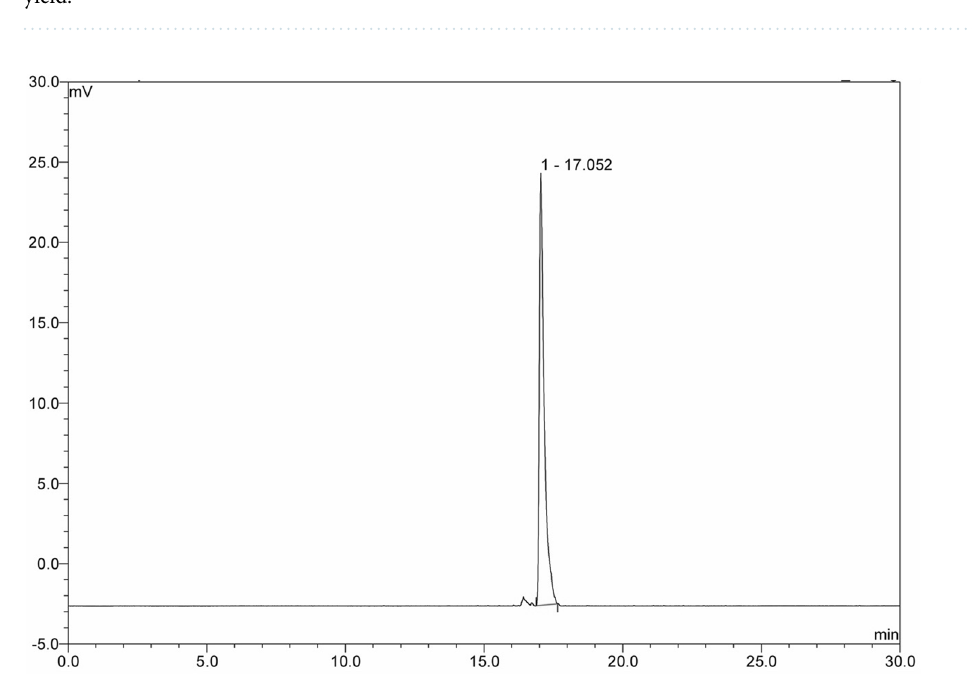
Figure 3. Figure showing radioactive peak for [ 18 F]AVT-011 at 17